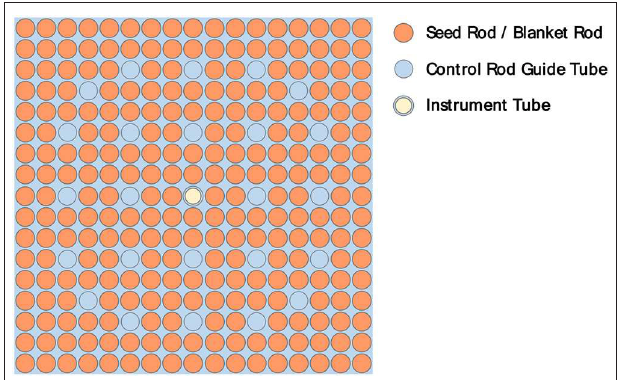
FIGURE 1 | Schematic of seed and blanket